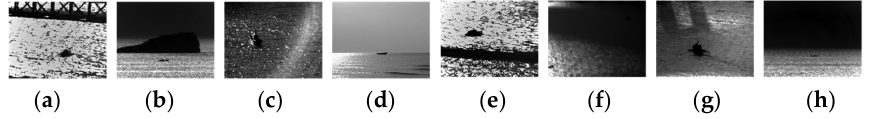
Figure 16. ( a – h ) is a representative images of each image sequence. Table 1. Experimental environment and image description of each image sequence.